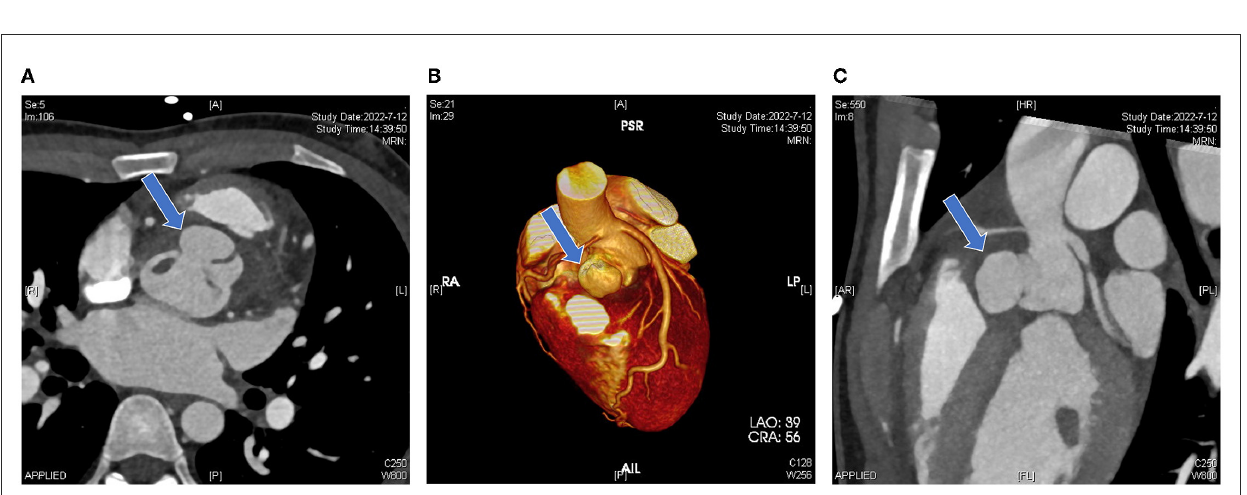
FIGURE2 Pre-operative computed tomography. (A) Irregular morphology of the coronary sinuses with local anterior protrusion (blue arrow). (B) A three-dimensional reconstruction image shows that the left coronary artery arises from above the left coronary sinus and the right coronary artery arises from above the junction of the left and right coronary sinuses. The aortic root bulge is shown in the blue arrow. (C) Sagittal view showing the vertical position of the bulge (blue